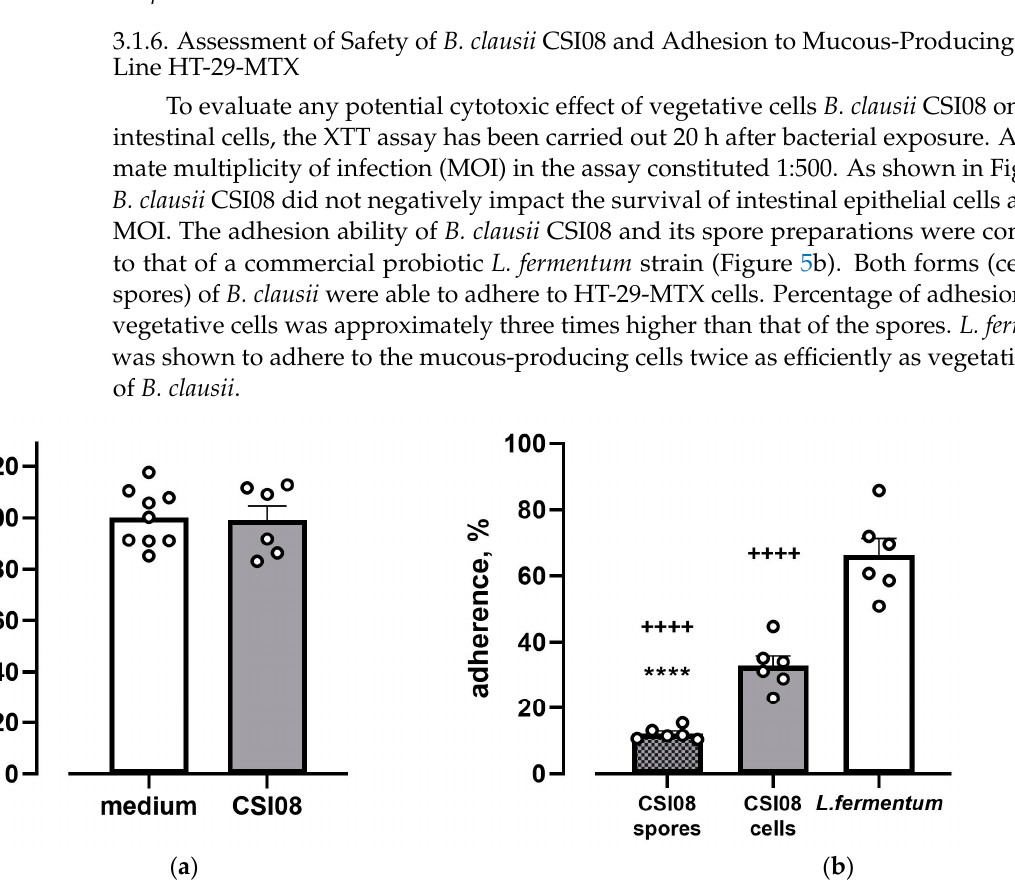
Figure 4. ( a ) Amino acids and ( b ) vitamins in B. clausii CSI08 supernatants (CFS) determined by HPLC-FLD and UHPLC-MS correspondingly. Values are means (n = 3) ± SEM. * p < 0.05, ** p < 0.01, **** p < 0.0001.